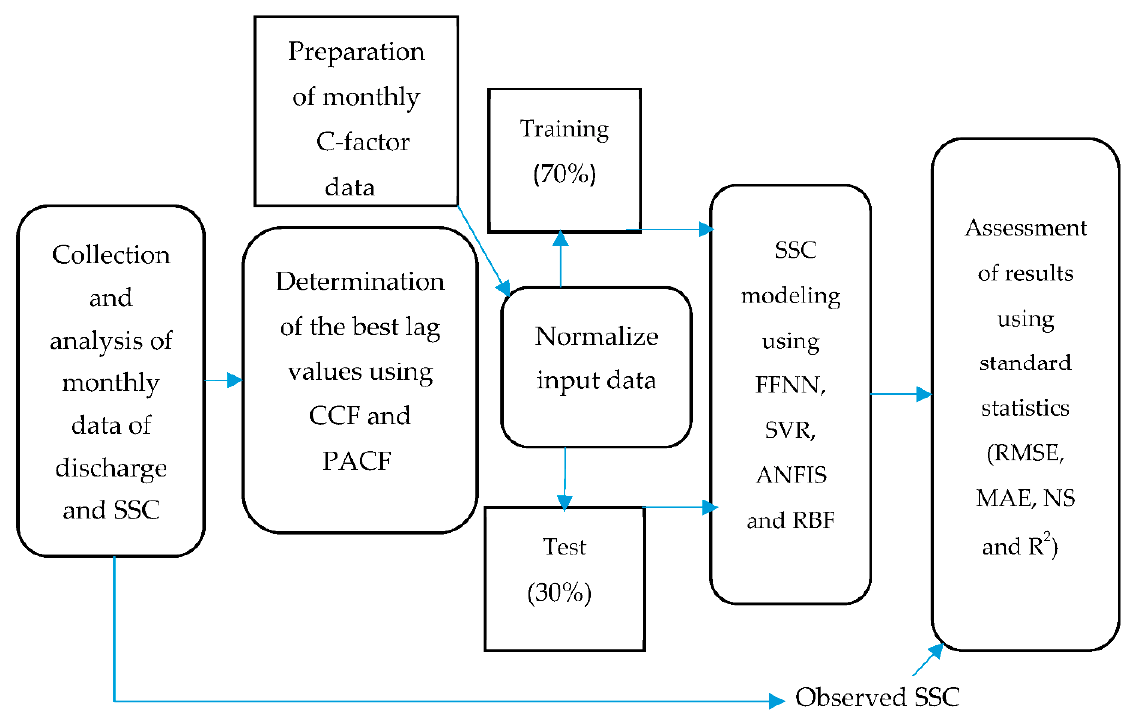
Figure 1. Flowchart of research methodology.